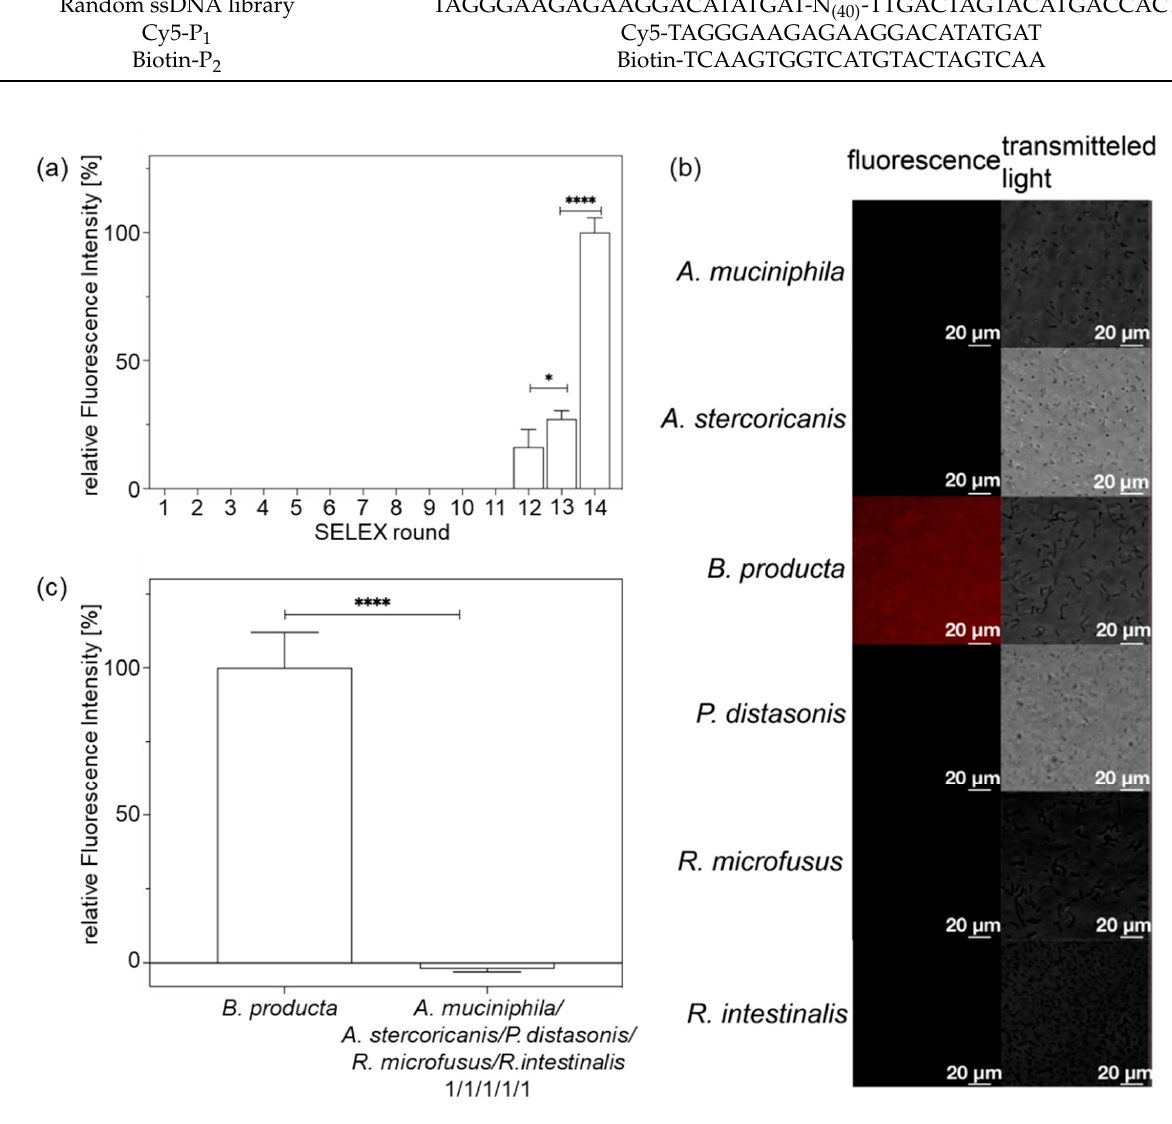
Figure 2. Specificity of the aptamer libraries. ( a ) Monitoring of the evolution process. After each round of selection, equal amounts of aptamer libraries were co ‐ incubated with B. producta (1 mL, OD 600 = 1), and then the Cy5 ‐ labelled aptamers were freed from the surface of B. producta by heating after three washes with 1×DPBS. The progressively enhanced fluorescence signal showed a gradual enrichment of the aptamer library recognizing B. producta . p values < 0.05 were considered signifi ‐ cant. * denotes p < 0.01, and **** p < 0.0001. ( b ) Fluorescence microscopy of Cy5 ‐ labelled polyclonal